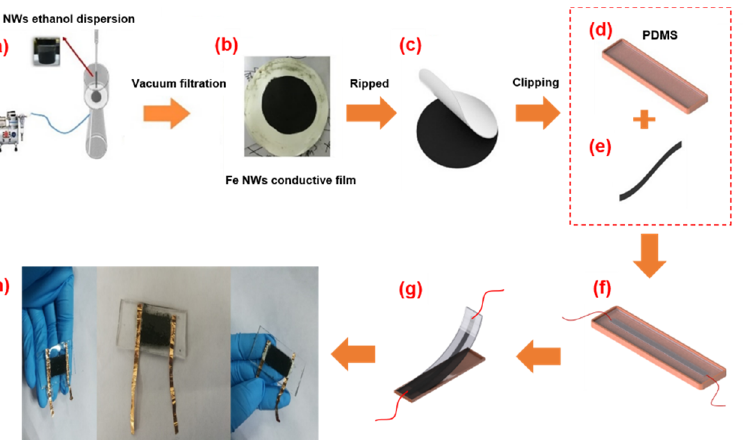
Figure 2. Construction process of flexible sensor based on Fe NWs: ( a ) vacuum filtration, ( b ) transfer, ( c ) shaping, ( d ) PDMS substrate, ( e ) tailoring, ( f ) sensor assembly, ( g ) sensor molding, and ( h ) an image of the sensor.